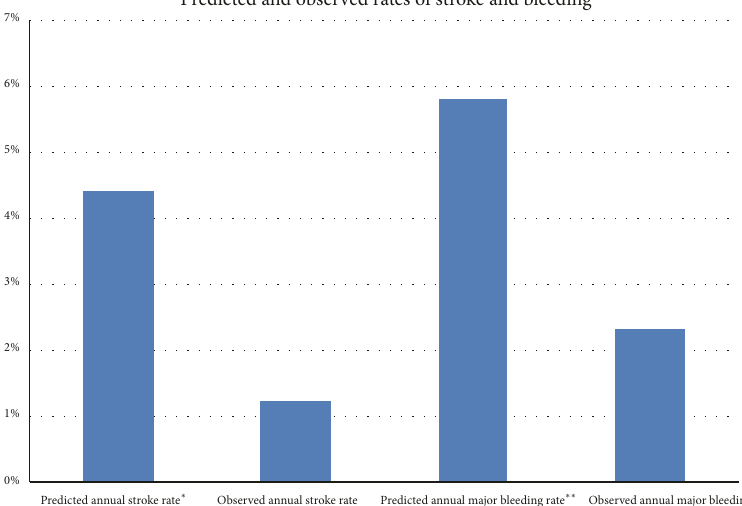
Figure 2: Predicted and observed rates of stroke and major bleeding . Effectiveness and safety of LAAO in reducing thromboembolic events and haemorrhagic complications. ∗ Calculated from CHAD